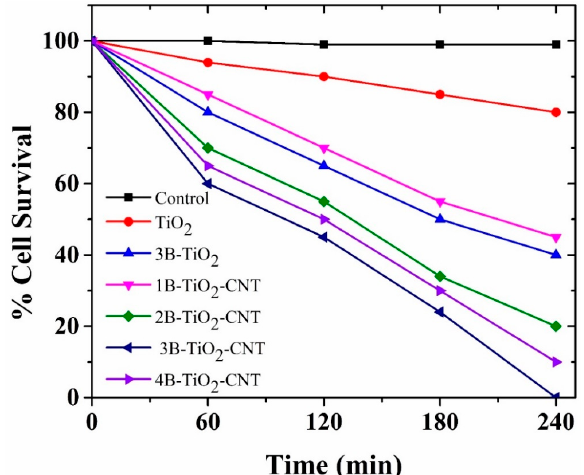
Figure 10. % survival of E. coli with of TiO 2 , 3B-TiO 2 and B-TiO 2 -CNT nanocomposites as a function of time.